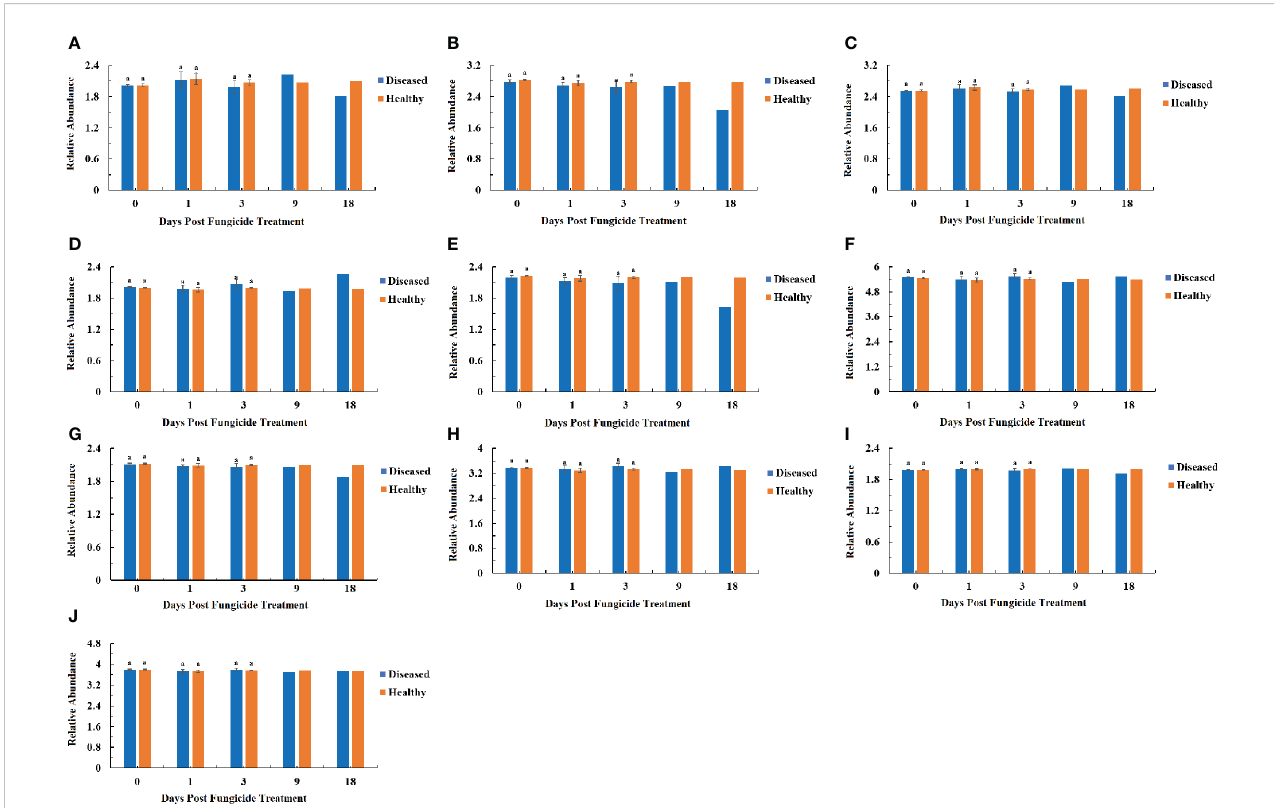
FIGURE 10 PICRUSt analyses of the changes in the KEGG level 3 functional categories of bacteria in tobacco leaf samples. (A) Ribosome, (B) Photosynthesis proteins, (C) DNA repair and recombination proteins, (D) Two component system, (E) Photosynthesis, (F) Peptidases, (G) Transporters, (H) ABC